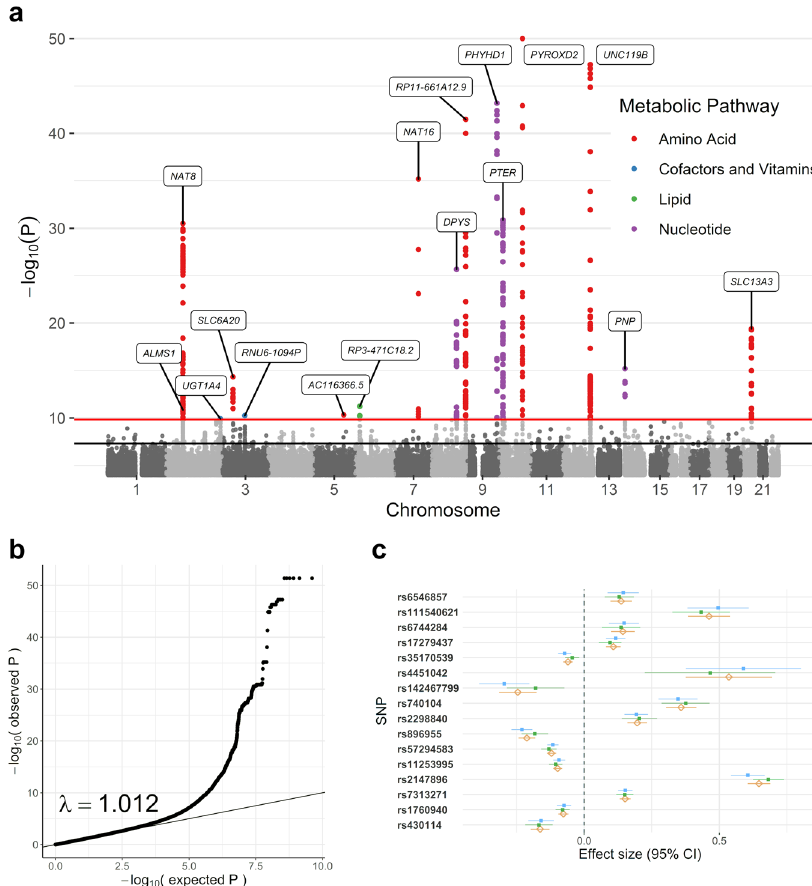
Fig. 1 Genome-wide association study (GWAS) meta-analysis of the CSF metabolome. a Manhattan plot of the meta-analysis across all 338 metabolites tested, with the signi fi cant SNPs colored by the metabolic pathway of the associated metabolite ( n = 291 meta-analyzed CSF samples). Age at CSF sample, sex, genotyping batch (WADRC only), and the fi rst fi ve principal components were controlled for in each individual GWAS. The top SNP of each locus is labeled with the nearest gene. The horizontal lines represent the genome-wide (5 × 10 − 8 , black) and Bonferroni-corrected signi fi cance thresholds (1.48 × 10 − 10 , red). Data points with P < 1 × 10 − 50 for N6-methyllysine are not shown. b Q – Q plot based on the meta-analysis across all metabolites. c Forest plot of the top SNPs from each signi fi cant locus across the discovery, replication, and meta-analysis ordered by chromosome and BP position. The blue point represents the discovery GWAS, green the replication GWAS, and beige the meta-analysis. The effect size refers to the GWAS beta-effect